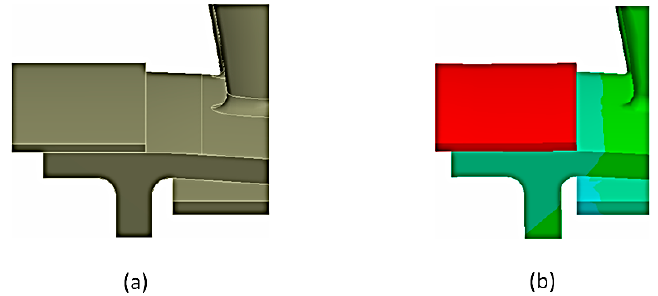
Figure 16. Coupling of the combustion chamber inner wall with the turbine stator. ( a ) Position at room temperature; ( b ) new position after thermal expansion.